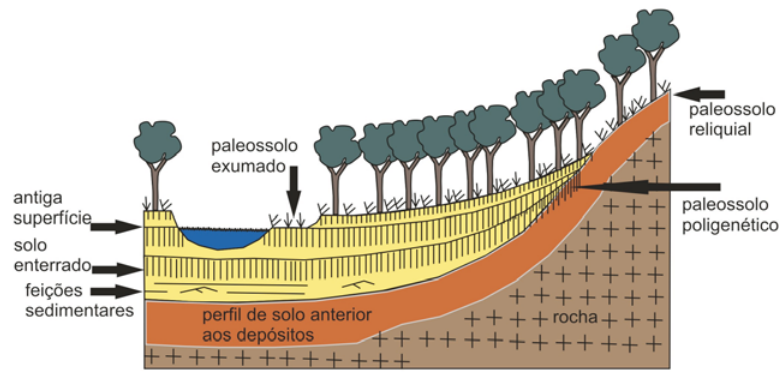
Figura 3. Paleossolos na paisagem. Fonte: Retallack